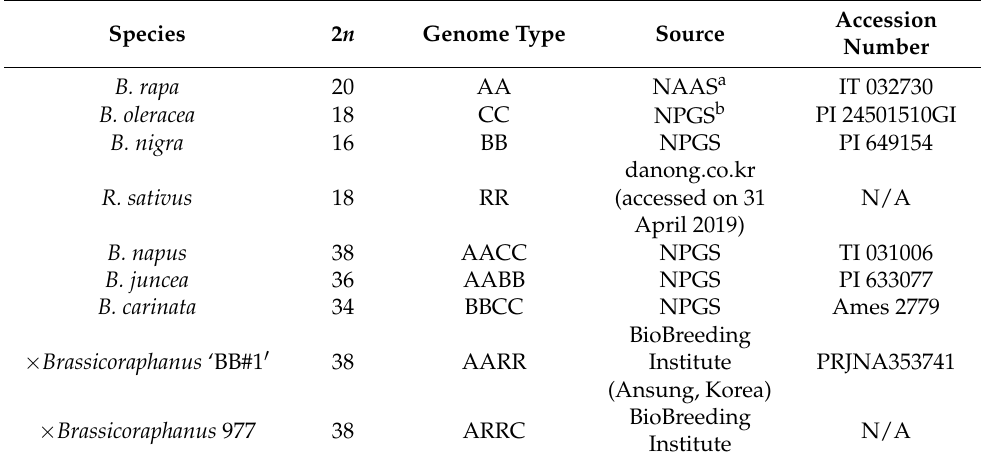
seed source, and accession